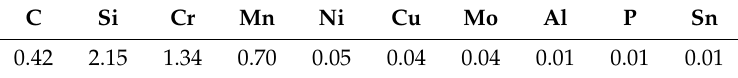
Figure 1. Initial microstructure of 42SiCr base material, optical microscopy. Table 1. Chemical composition of investigated alloy 42SiCr.